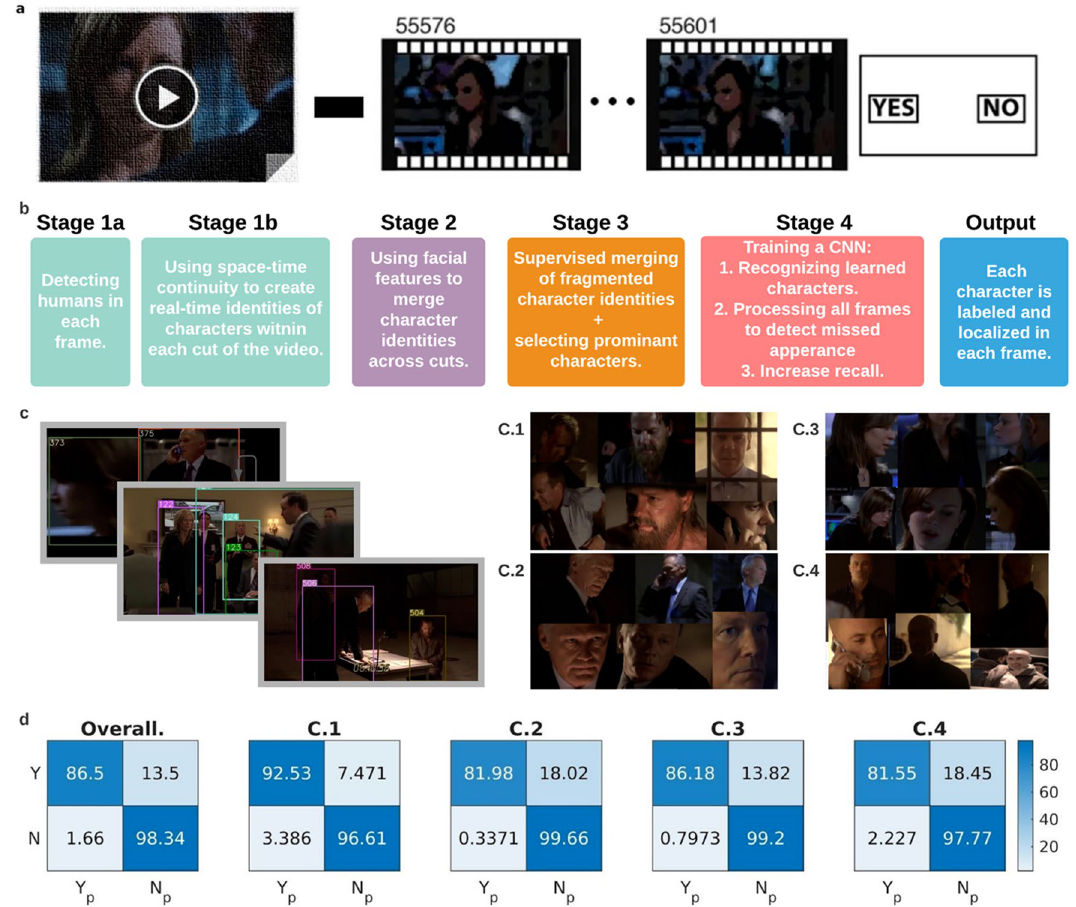
Figure 1. Schematic of the task and the pipeline for semi-supervised character extraction. ( a. ) The task consisted of viewing an episode of the 24 TV series followed by a recognition memory test. During the memory test, participants were shown short clips and were asked whether they had previously seen the clip or not. ( b. ) A brief overview of the algorithm used for character extraction. For a more detailed version, see Supplementary Fig. 1) ( c. ) Example outputs of the character extraction algorithm at different steps: Left) output of stage 1 (extracting humans in each frame); Right) output of stage 4 (sample different appearances for each of the four main characters C.1 through C.4) ( d. ) To test the performance of our character extraction algorithm, we used character labels that were manually created in an independent study 7 ⁠ . Shown are the normalized confusion matrices of individual characters (right) as well as the overall confusion matrix (left). Yp and Np correspond to predicted yes and predicted no respectively. Note the darker colors along the diagonal showing large percentages of true positives and true negatives indicative of high